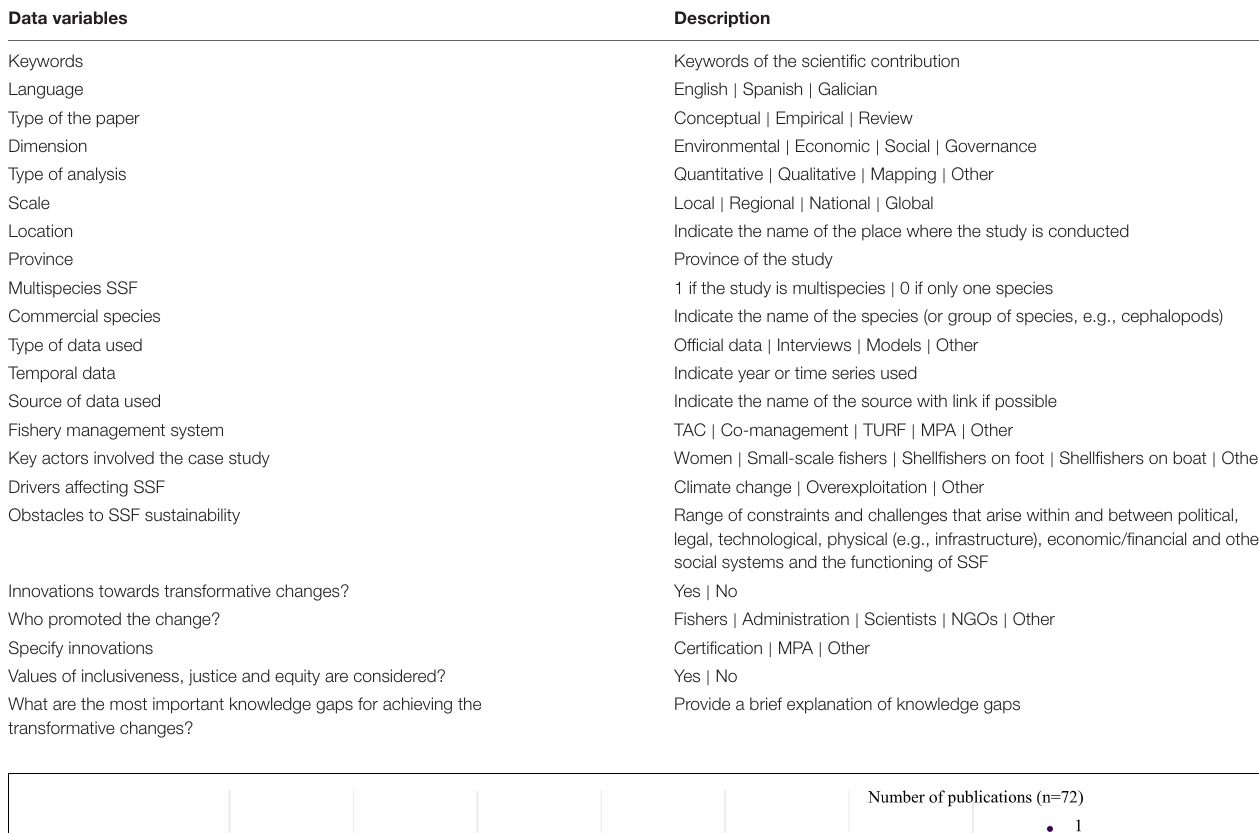
TABLE 1 | Data variables and corresponding categories used to collect data in the systematic literature